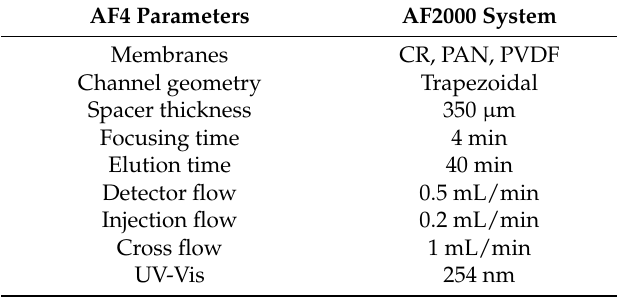
Table 1. Analytical parameters and characteristics of asymmetric flow field flow fractionation